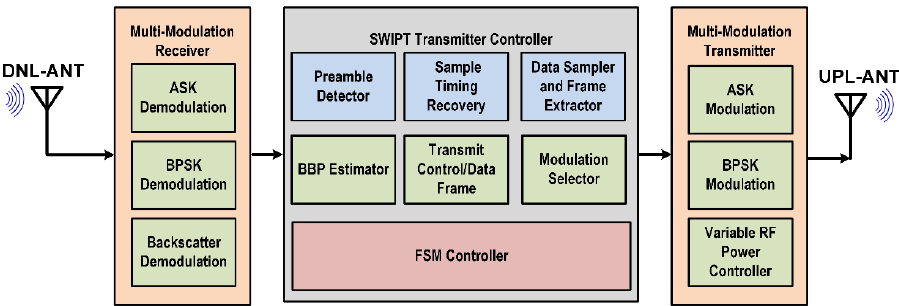
Figure 1. Architecture of the proposed simultaneous wireless information and power transfer (SWIPT) transmitter with the adaptive control and communication protocol (ACCP). adaptive control and communication protocol